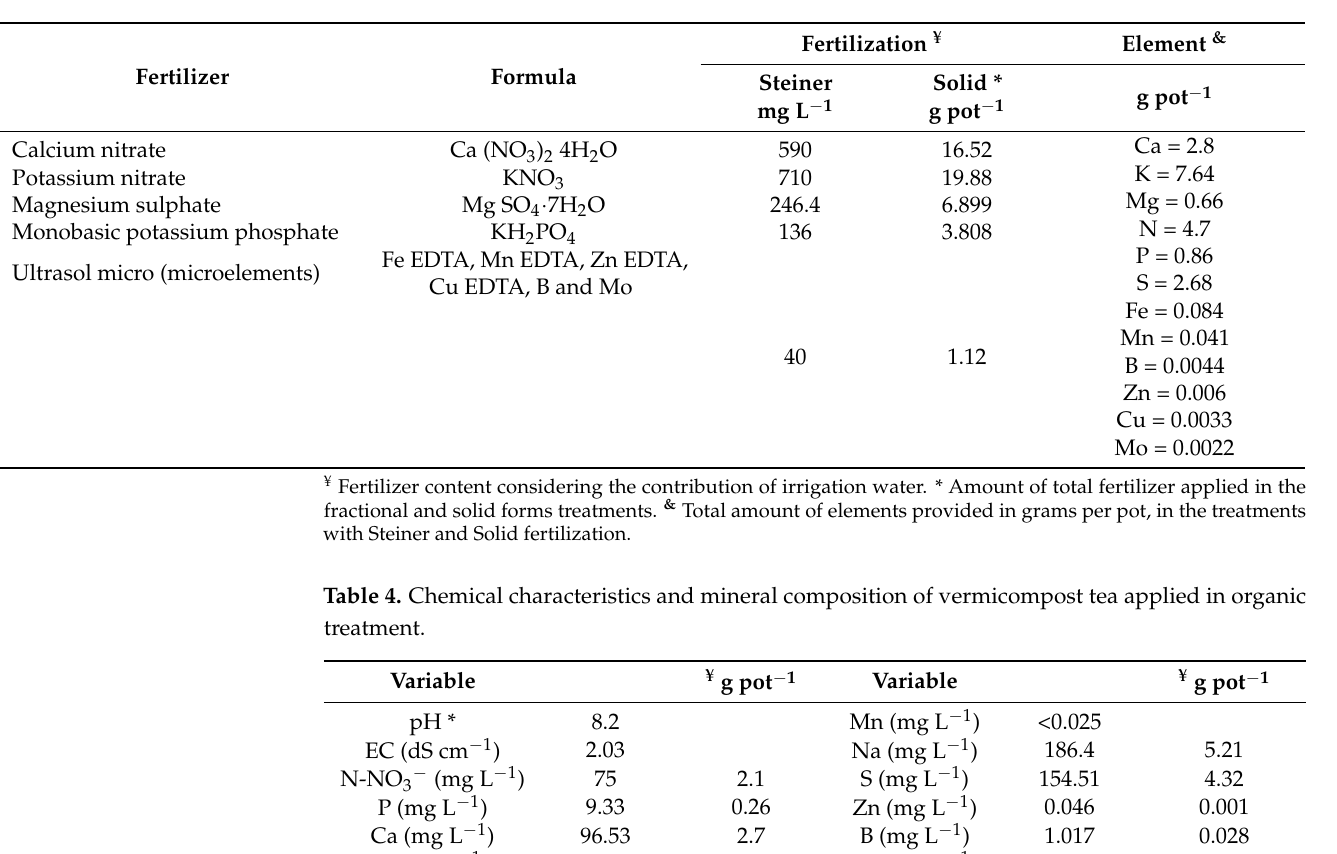
Table 3. Fertilizers used in the preparation of the nutrient solution and in the application of the treatment in solid and fractioned form.